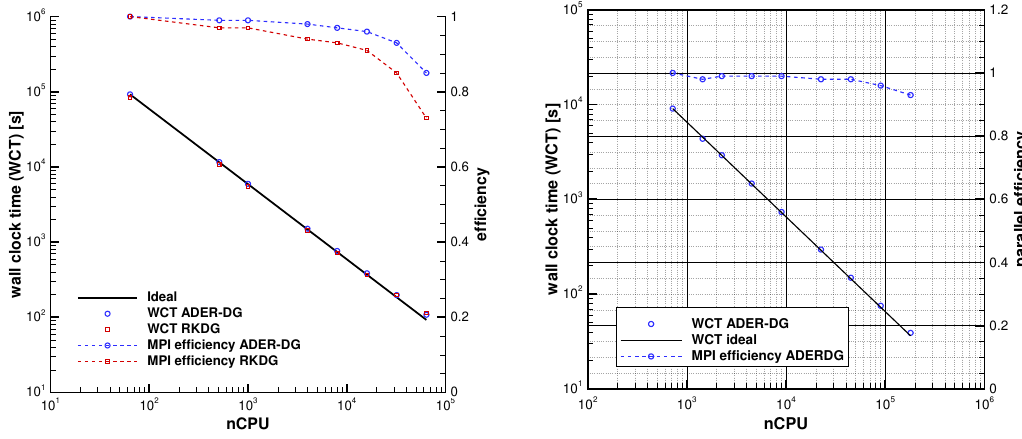
Figure 10. Strong MPI scaling study of ADER-DG schemes for the novel FO-CCZ4 formulation of the Einstein field equations recently proposed in Reference [129]. ( Left ) comparison of ADER-DG schemes with conventional Runge-Kutta DG schemes from 64 to 64,000 CPU cores on the SuperMUC phase 1 system of the LRZ supercomputing center (Garching, Germany). ( Right ) strong scaling study from 720 to 180,000 CPU cores, including a full machine run on the Hazel Hen supercomputer of HLRS (Stuttgart, Germany) with ADER-DG schemes ( right ). Even on the full machine we observe still more than 90% of parallel